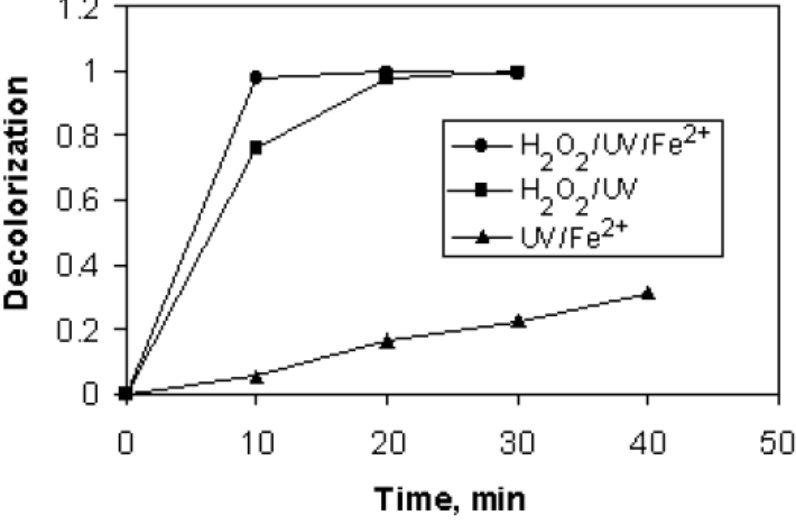
Fig. 5 The decolorization variation in different AOPs. Initial conditions: C dye =50 mg/L, pH=6.12, [H 2 O 2 ]= 17.318 mM, [Fe 2+ ]= 7.03.10 − 2